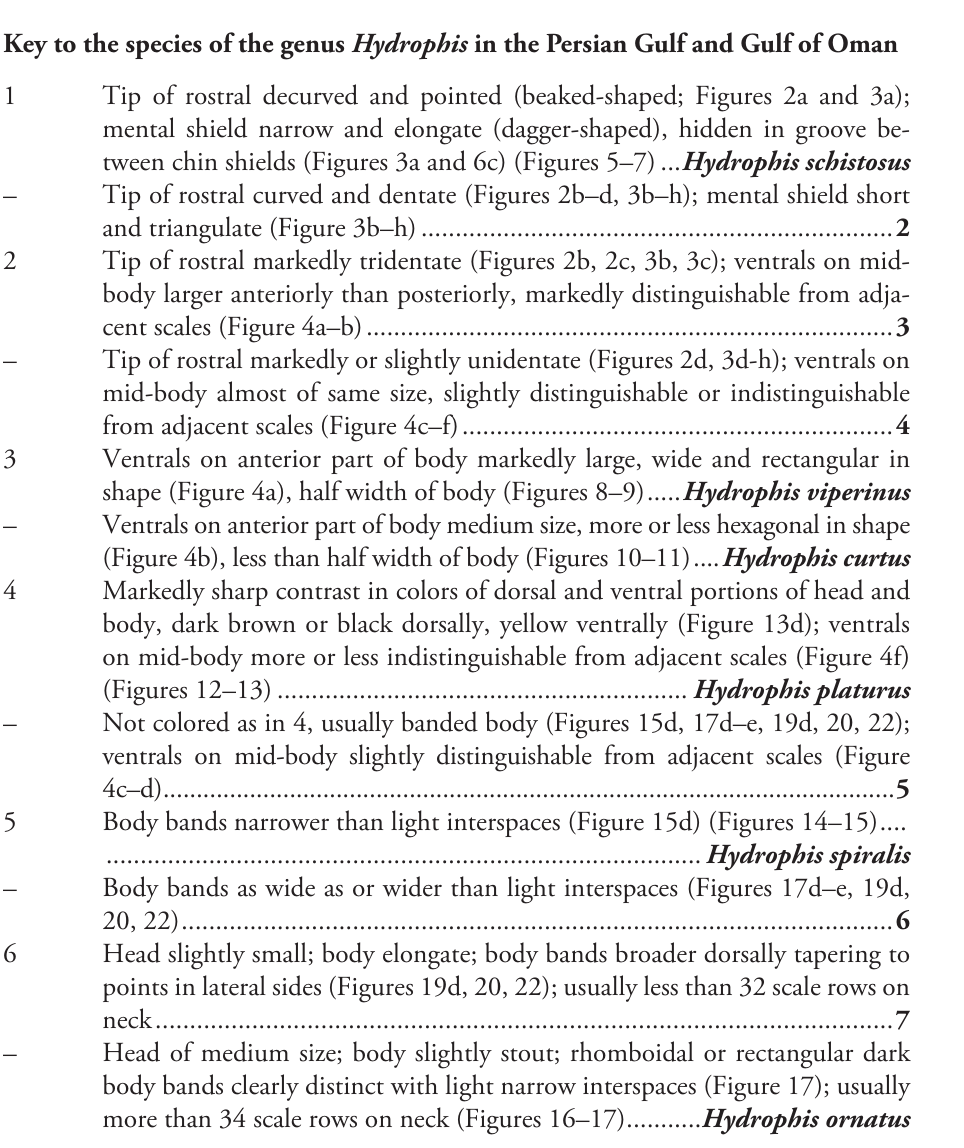
Key to the genera of the subfamily Hydrophiinae in the Persian Gulf and Gulf of Oman 1 Head extremely small; neck markedly slender; usually 5–6 supralabials; usually less than 25 scale rows on neck (Figures 23–26) .................. Microcephalophis – Head and neck not as in 1; usually more than 6 supralabials; usually more than 25 scale rows on neck (Figures 5–22) ................................... Hydrophis